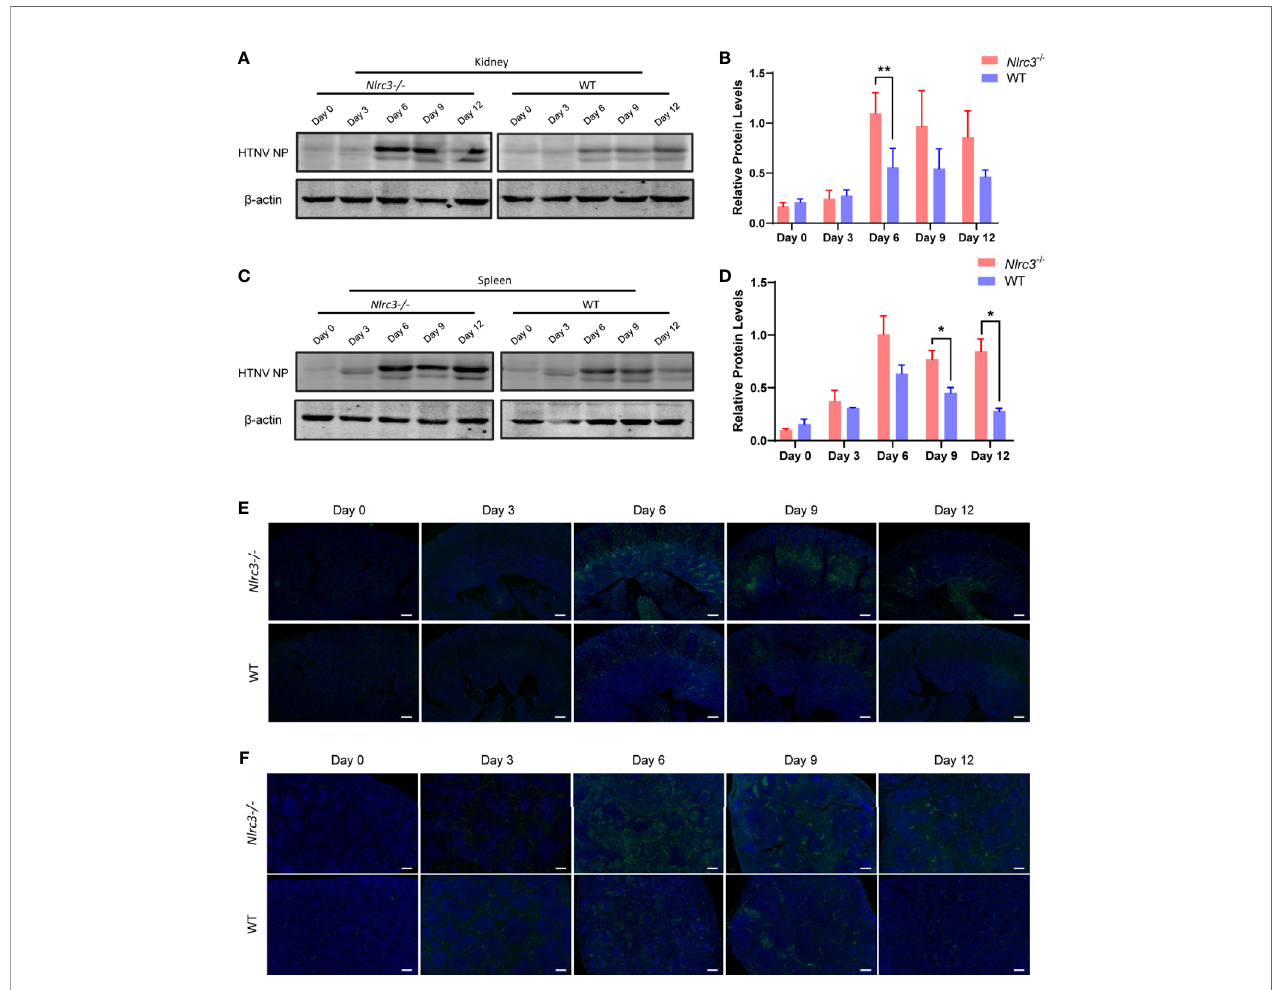
FIGURE 2 | Expression levels of HTNV nucleoprotein (NP) in spleen and kidney samples obtained from Nlrc3 − / − and WT mice after viral challenge. Samples were collected on 3, 6, 9, and 12 dpi for Western blot and immunohistochemistry (IHC) analysis. (A) Western blot results of the kidneys of Nlrc3 − / − and WT mice. Lanes represent corresponding time points. (B) Densitometric analysis of band intensity for A ( Nlrc3 − / − mice, n=15; WT mice, n=10). (C) Western blot results of the spleens. (D) Densitometric analysis of band intensity for C ( Nlrc3 − / − mice, n=25; WT mice, n=20). IHC staining of mouse kidney (E) and spleen sections (F) to detect HTNV nucleocapsid protein in Nlrc3 − / − (top) and WT mice (bottom) after infection. HTNV NP (green), and DAPI (blue). IHC images are representative of at least three samples. Scale bars, 50 m m. *p < 0.05; **p <